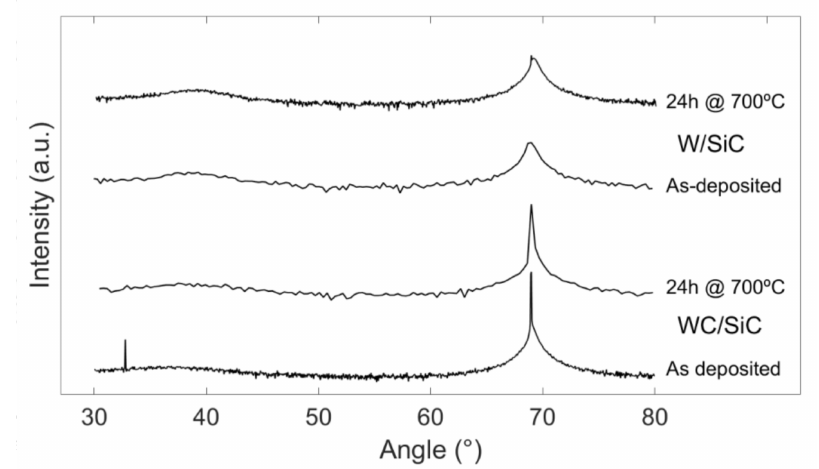
Figure 12. HAXRD spectra of as-deposited and annealed W/SiC (3.8 nm) and WC/SiC (3.8 nm) multilayers. The samples were annealed to 700 ◦ C for 24